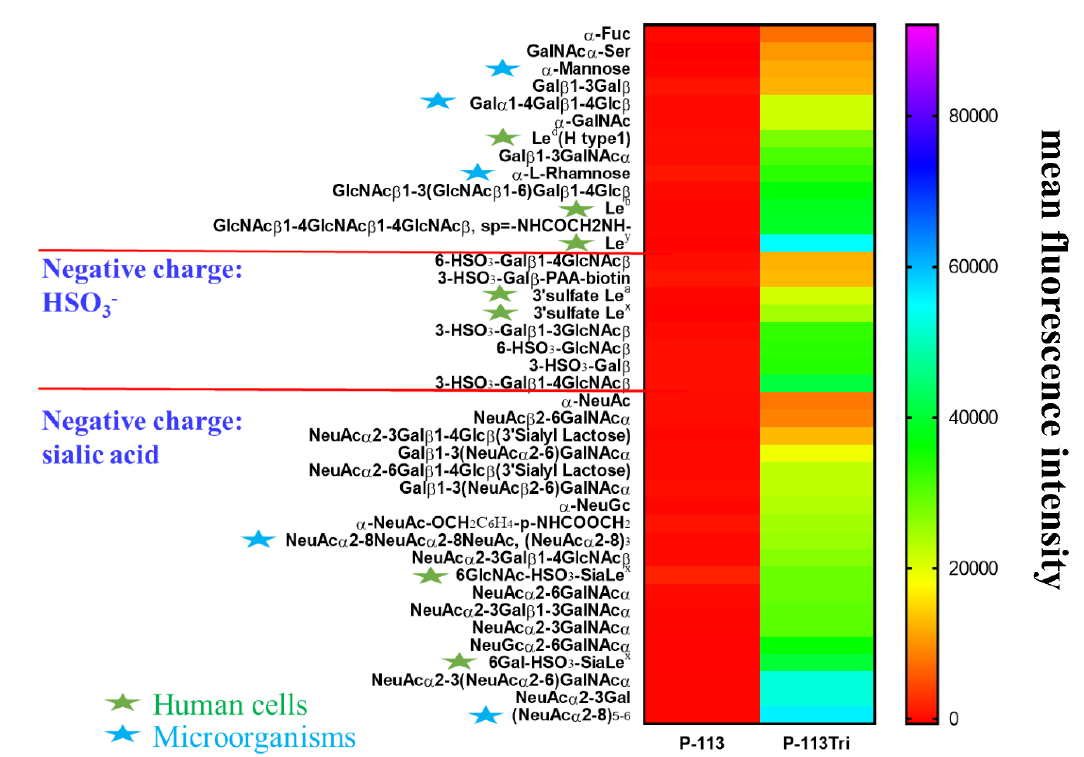
Figure 5. Screening of carbohydrate targets for the peptides using a solution carbohydrate array. The array contained different terminal sequences of N -glycans, O -glycans, and glycosphingolipids of microbial cells and mammalian tissues. Briefly, donor beads (500 ng / well) and biotin-PAA-sugars were mixed with FITC-P-113 and FITC-P-113Tri. Subsequently, a mixture of acceptor beads, mouse anti-FITC antibody, and rabbit anti-mouse IgG antibody was added. The binding signals were analyzed with a PerkinElmer Envision instrument using AlphaScreen TM . The top 40 glycans with peptide binding are shown. Le d (H type 1): Fucα1-2Galβ1-3GlcNAcβ, Le b : Fucα1-2Galβ1-3(Fucα1-